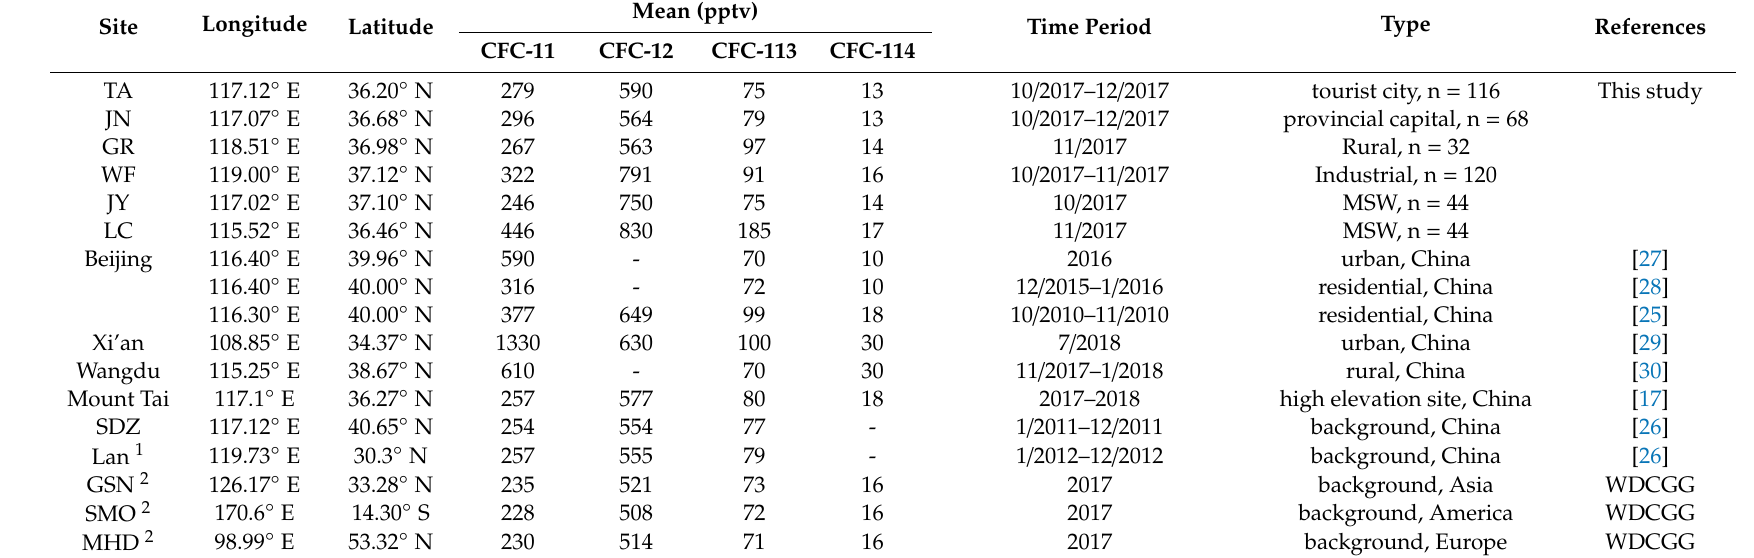
Table 1. Comparison of the mean concentrations for CFCs measured in this study and background